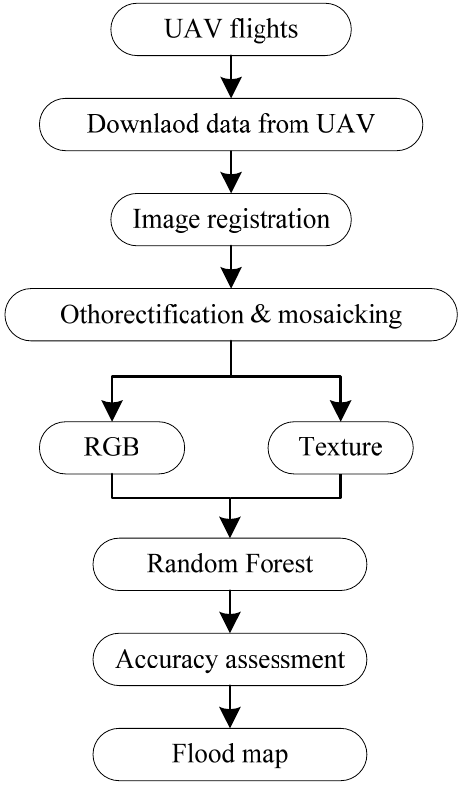
Figure 2. Workflow of urban flood